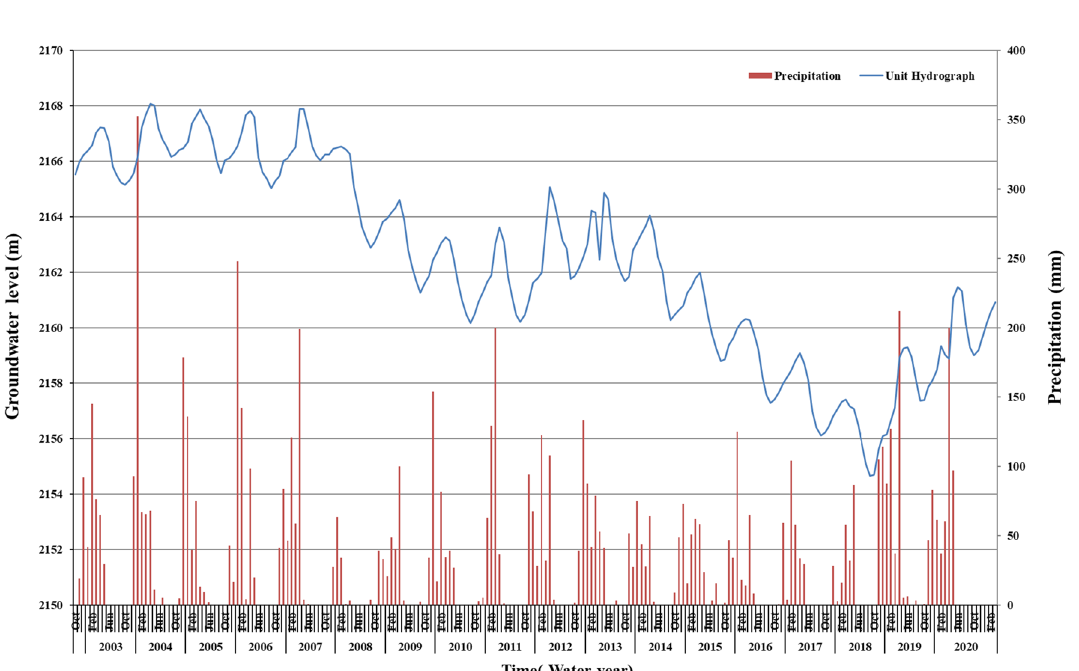
Fig. 2 Unit Hydrograph of groundwater in the Aspas